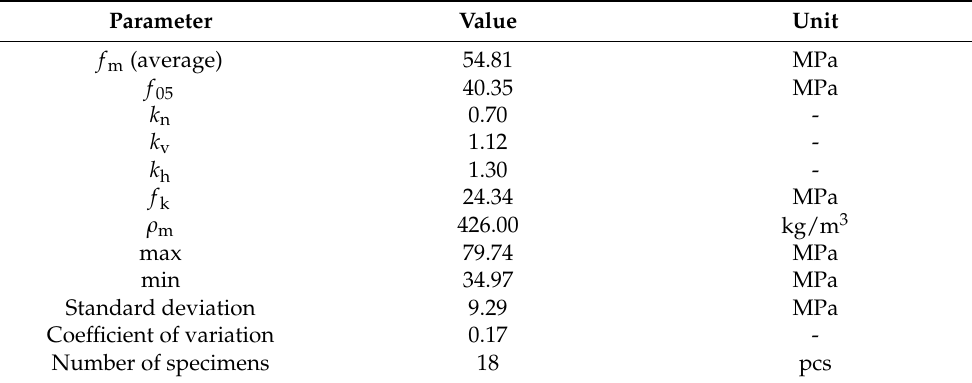
Figure 2. Four-point flexural strength test: ( a ) test scheme; ( b ) before test; and ( c ) after test. Table 1. Results of the four-point flexural strength test